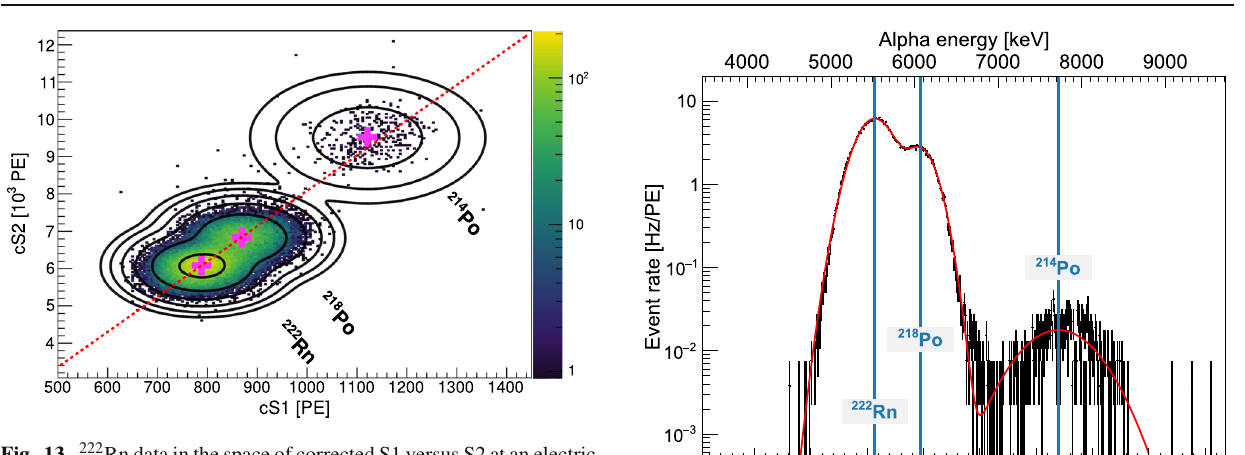
Fig. 13 222 Rn data in the space of corrected S1 versus S2 at an electric drift-field of 1.24kV/cm. The estimated mean S1 and S2 signal sizes of the three isotopes are indicated by the pink markers.The contour lines of the fit (sum of three individual 2D-Gaussian functions) are drawn in black. The dashed red line shows the linear fit through the fitted mean positions